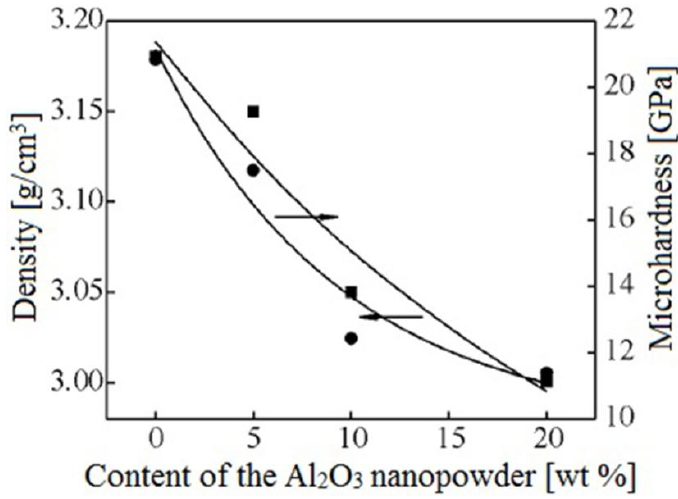
Figure 34. The dependence of the density and microhardness of the samples sintered from Al O nanopowders on the content of the Al 2 3